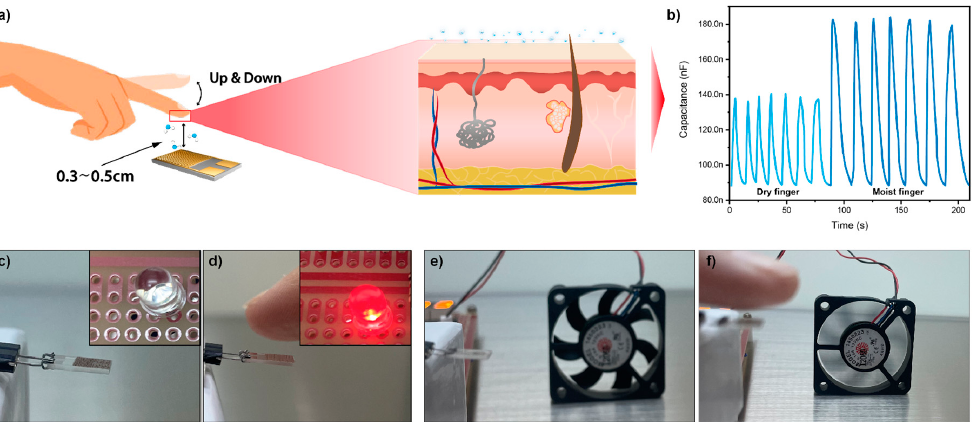
Figure 4. Measurements of the GO-doped P(VDF-TrFE)/LiCl-based sensor with noncontact results. ( a ) Noncontact sensing of moisture on the human skin. ( b ) Results of noncontact sensing. ( c , d ) non- contact moisture detection for the on/off of an LED light. ( e , f ) Noncontact moisture detection for the on/off switching of an electric fan.